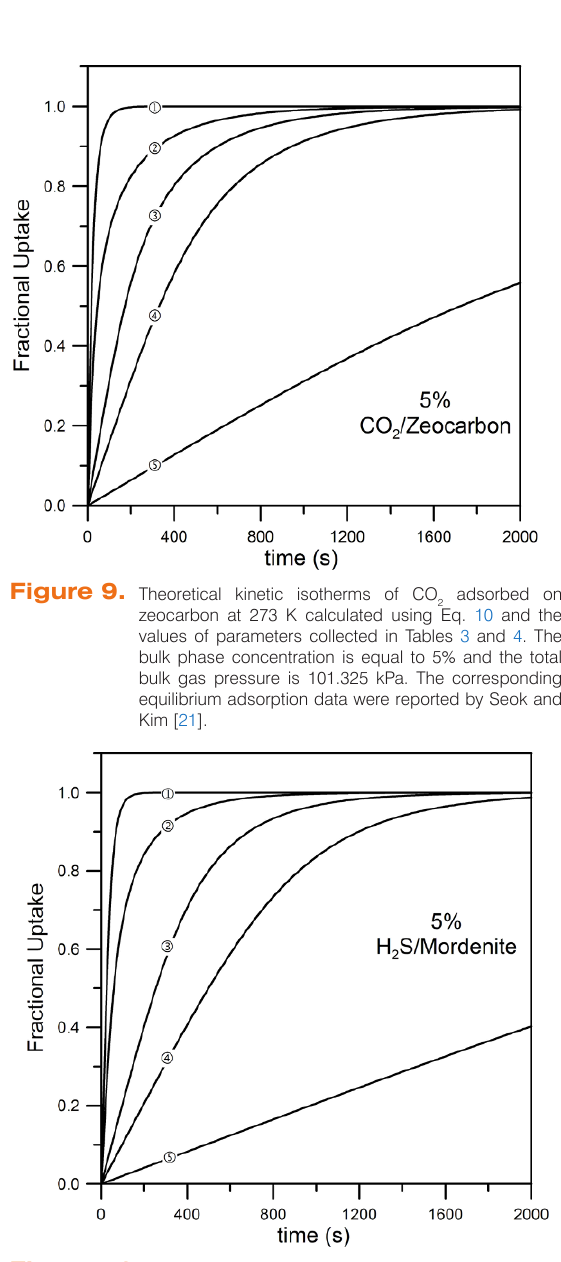
Figure 10. Theoretical kinetic isotherms of H Figure 8. Theoretical kinetic isotherms of CO adsorbed on S adsorbed on 2 2 H-mordenite at 283 K calculated using Eq. 10 and the H-mordenite at 283 K calculated using Eq. 10 and the values of parameters collected in Tables 3 and 4. The values of parameters collected in Tables 3 and 4. The bulk phase concentration is equal to 5% and the total bulk phase concentration is equal to 5% and the total bulk gas pressure is 101.325 kPa. The corresponding bulk gas pressure is 101.325 kPa. The corresponding equilibrium adsorption data were reported by Talu and equilibrium adsorption data were reported by Talu and Zwiebel [20]. Zwiebel